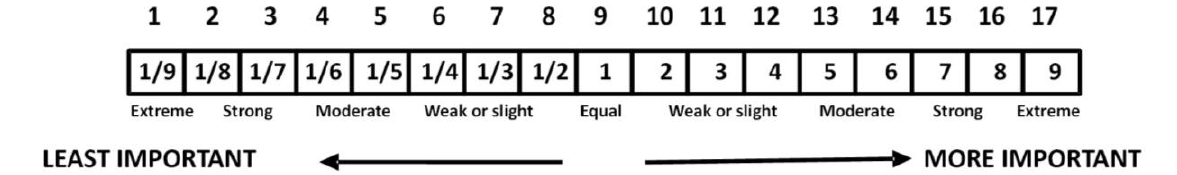
Fig. 5. Hierarchical scale of 17 relative importance of the construction of the comparison matrix between factor pairs or variables (Aguilar et al.,